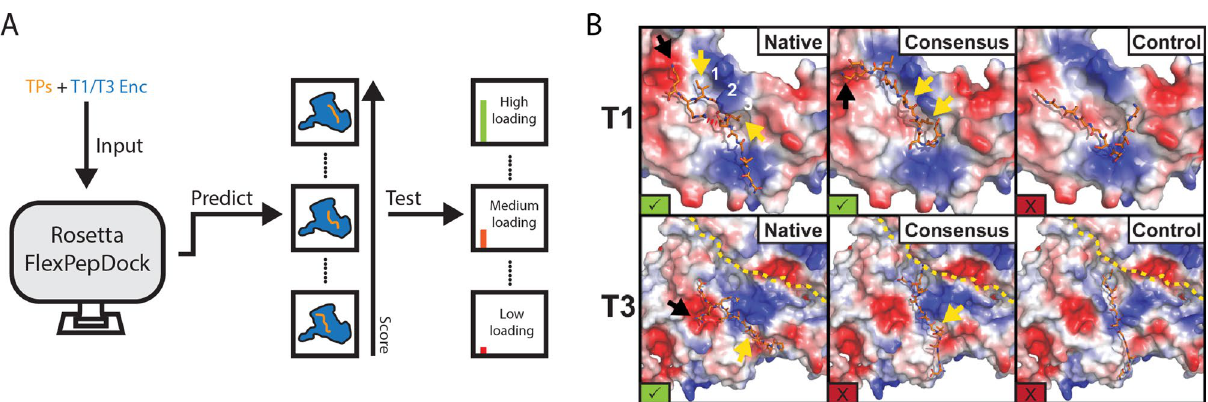
Figure 2. Flexible docking predicts shell-targeting peptide interactions and relative binding strength. ( A ) Schematic of combined computational and experimental workflow. ( B ) For some peptides, force-field docking found top-scoring TP conformations with sufficient ionic (black arrow) and hydrophobic (yellow arrow) interactions to bind encapsulin (green check mark). For others (red X), insufficient interactions were found to expect binding. The binding surface of T3 crosses two subunits (protomers separated by yellow